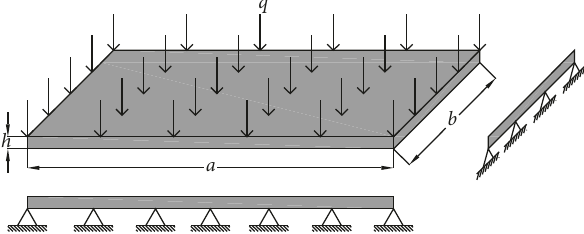
Figure 3: Schematic representation of the plate with the loading and boundary Table 1: Statistical parameters used in the present study.